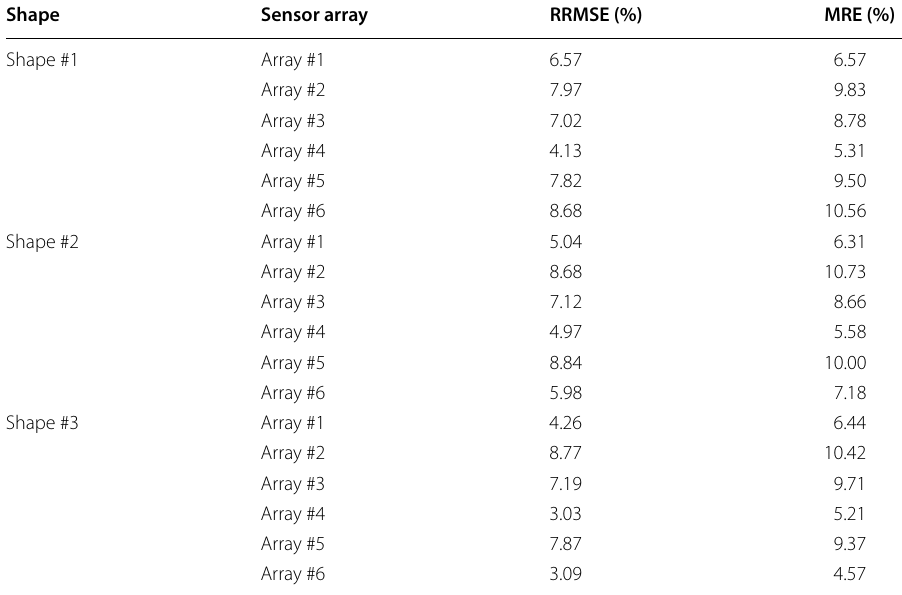
Table 6 Reconstruction error statistics